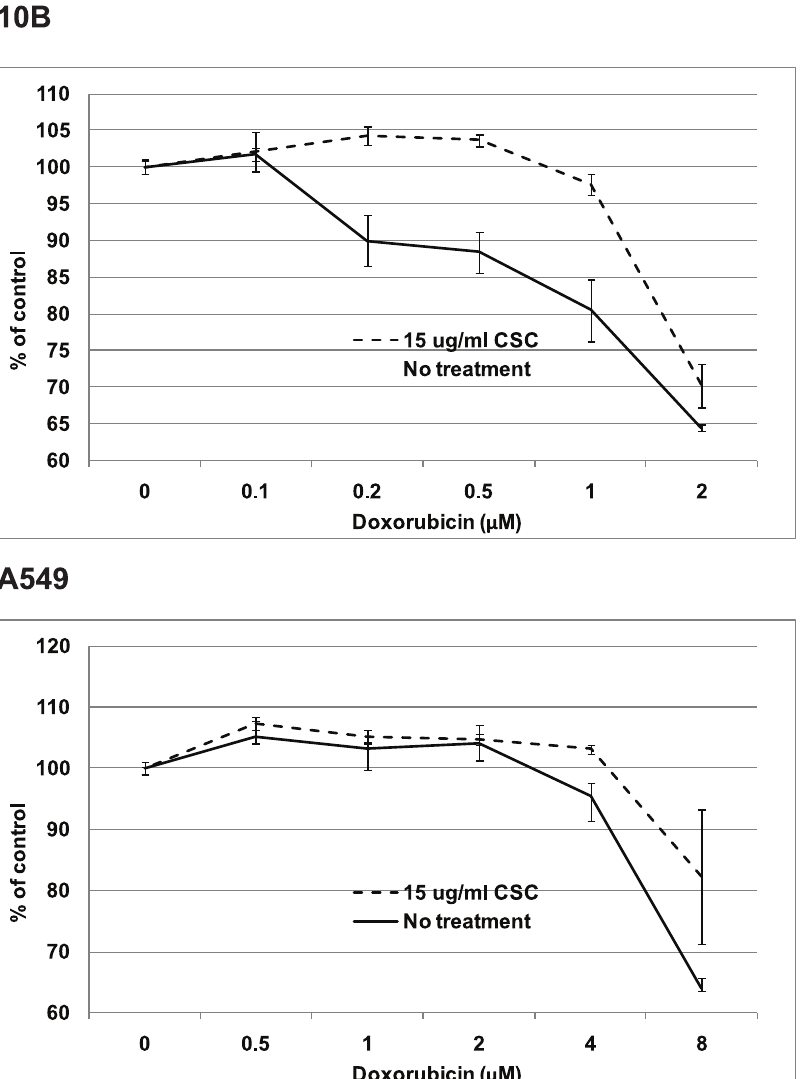
Figure 6. CSC treated cells show enhanced viability during doxorubicin exposure. MTS cell viability assays testing the viability of control vs. CSC-treated 10B and A549 cells in the presence of doxorubicin. Absorbance (Y-axis) values were normalized by dividing over the absorbance of the 0 m M doxorubicin samples. Results indicate that CSC has a protective effect against doxorubicin-induced cell death. Error bars represent SEM.